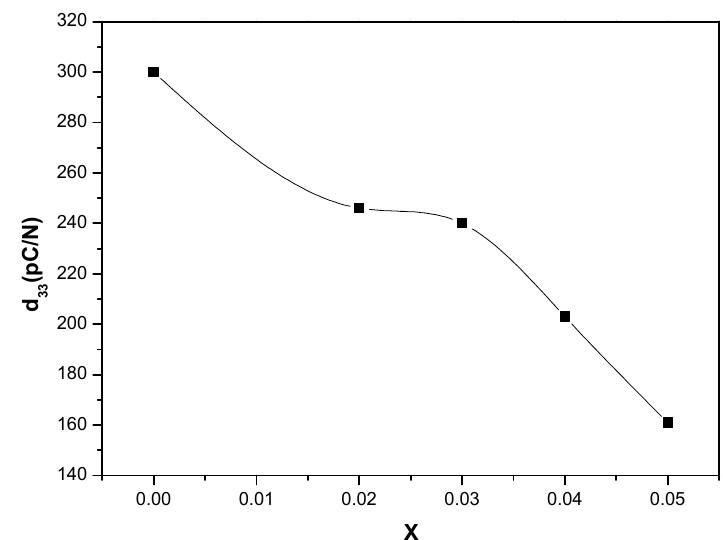
Figure 7. Piezoelectric constant (d 33 ) of specimens with x.